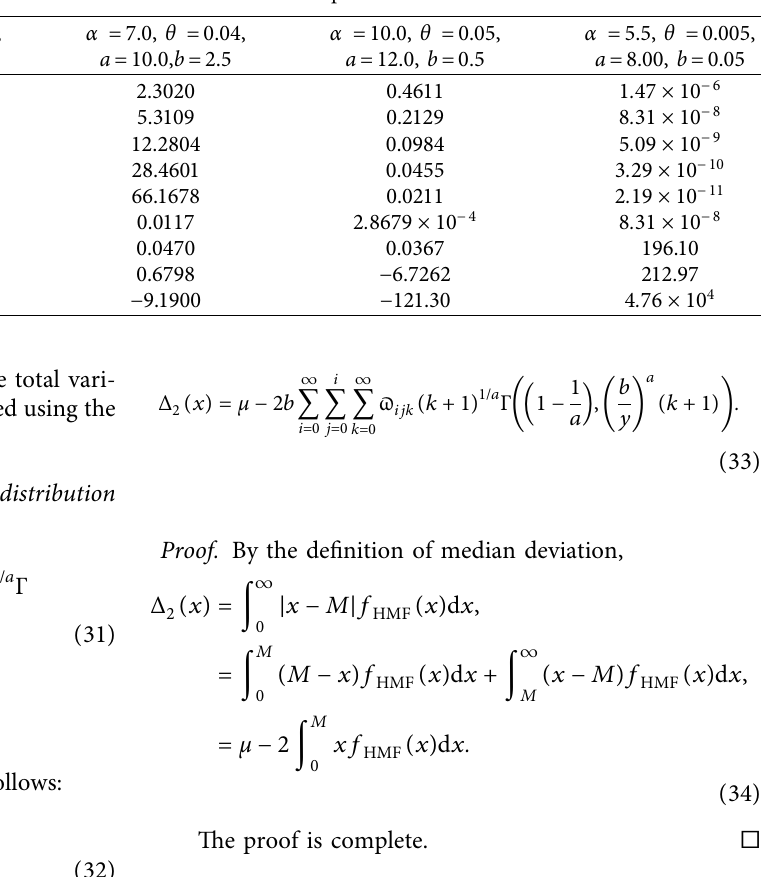
Table 2: HMF distribution of first five moments for some parameter